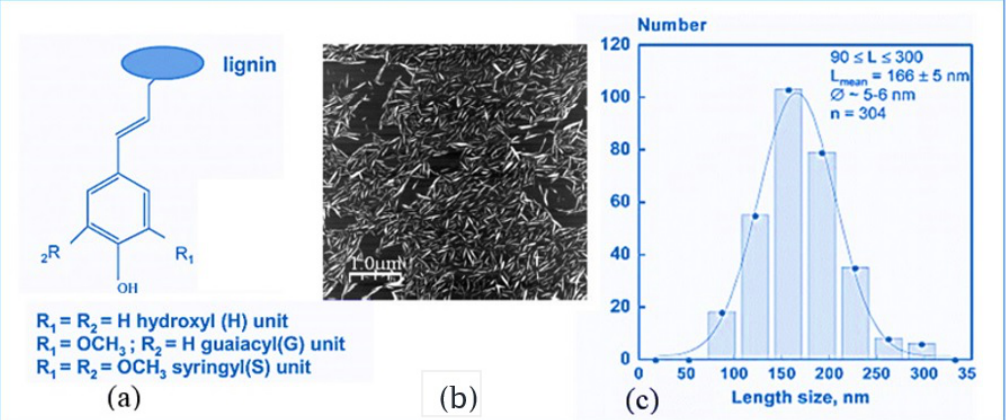
Figure 3. ( a ) The chemical structure of the monomer units found in lignin; ( b ) AFM image of cellulose nanocrystals after acid hydrolysis and ( c ) the average length of the monomer unit found in lignin. Reprinted (adapted) with permission from [31], copyright (2016) American Chemical